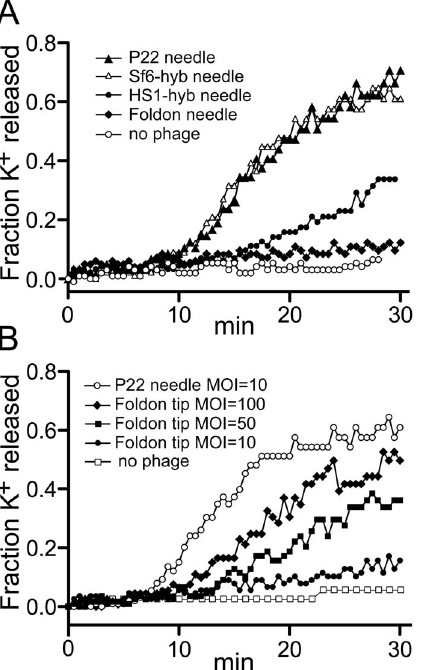
Figure 5. Potassium ion release by P22 phages with modified tail needles. A. Infection of Salmonella strain UB-0001 by P22 phages with altered needle proteins at MOI=10. Potassium ion release was measured at 30 u C as described in Materials and methods with a potassium electrode. Salmonella host strain UB-0001 was infected by the following phages: UC-0911 fully P22 tail needle ( m ); UC-0918, N needle has Sf6 C-terminal knob domain and part of the shaft ( n ); UC- ); UC-0927, foldon 0926, needle has HS1 C-terminal knob domain ( replaces needle C-terminal domain ( X ); no phage infection ( # ). B. Infection of Salmonella strain UB-0001 by P22 phages with foldon- tipped needle at various MOIs as follows: P22 UC-0911 with fully P22 tail N needle at MOI=10 ( # ); P22 UC-0927 where foldon replaces needle’s C- ), MOI=50 ( & ) and MOI=100 ( X ); no terminal domain at MOI=10 ( phage ( % ). The horizontal axis is time after